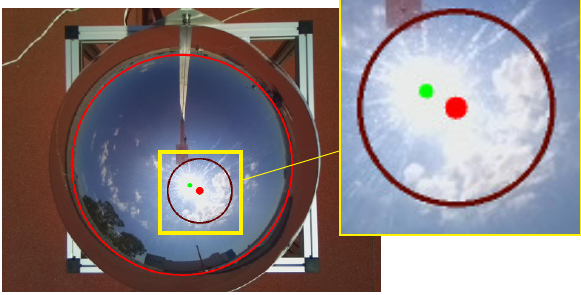
Figure 9. Correction of the Sun’s position through